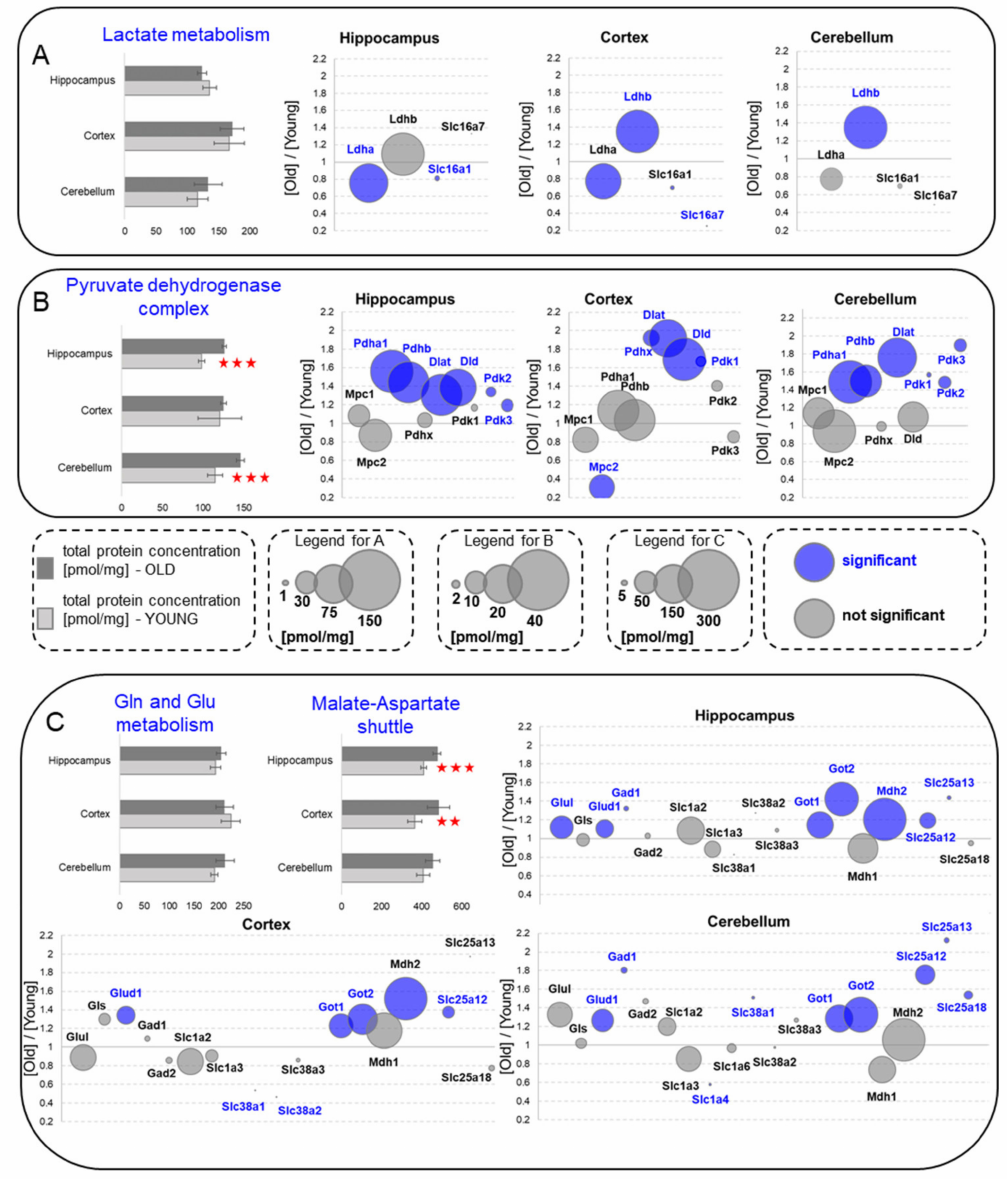
Figure 4. Changes in the energy metabolism processes upon aging—lactate, pyruvate and glutamine as energy sources. ( A ) Lactate metabolism. ( B ) Pyruvate dehydrogenase complex. ( C ) Glutamine/glutamate metabolism with the malate- aspartate shuttle. Column plots show total protein concentration summarizing each metabolic pathway for young and old animals in the hippocampus, cortex and cerebellum. The statistically significant changes between age groups are indicated (** p < 0.01, *** p < 0.001). Bubble plots show ratios of protein concentrations in the old vs. young hippocampus, cortex and cerebellum. The size of the bubbles is proportional to an average protein concentration. Proteins with significantly changed concentrations are highlighted in blue. Abbreviations: YOUNG—1-month-old and OLD—22-month-old